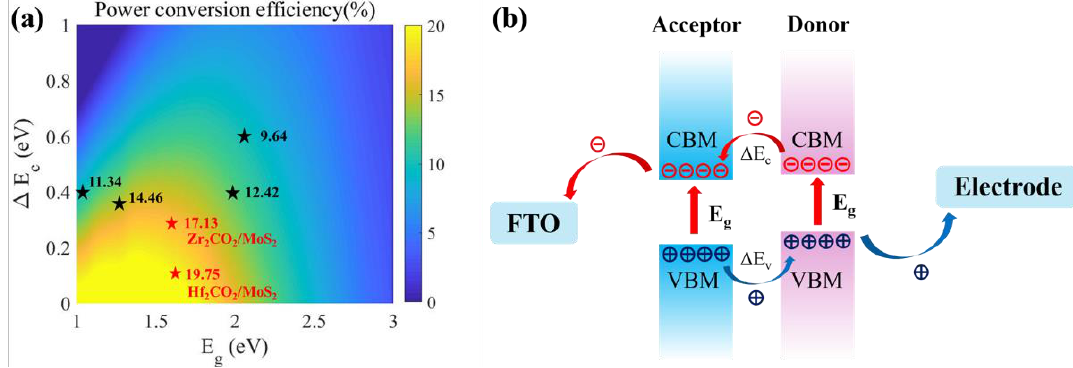
Figure 10. ( a ) A simulated PCE map refers to the donor band gap and conduction band offset of M 2 CO 2 /MoX 2 heterostructures. ( b ) Schematic illustration of free charge carrier transfer path in M 2 CO 2 /MoX 2 heterostructure solar cells.